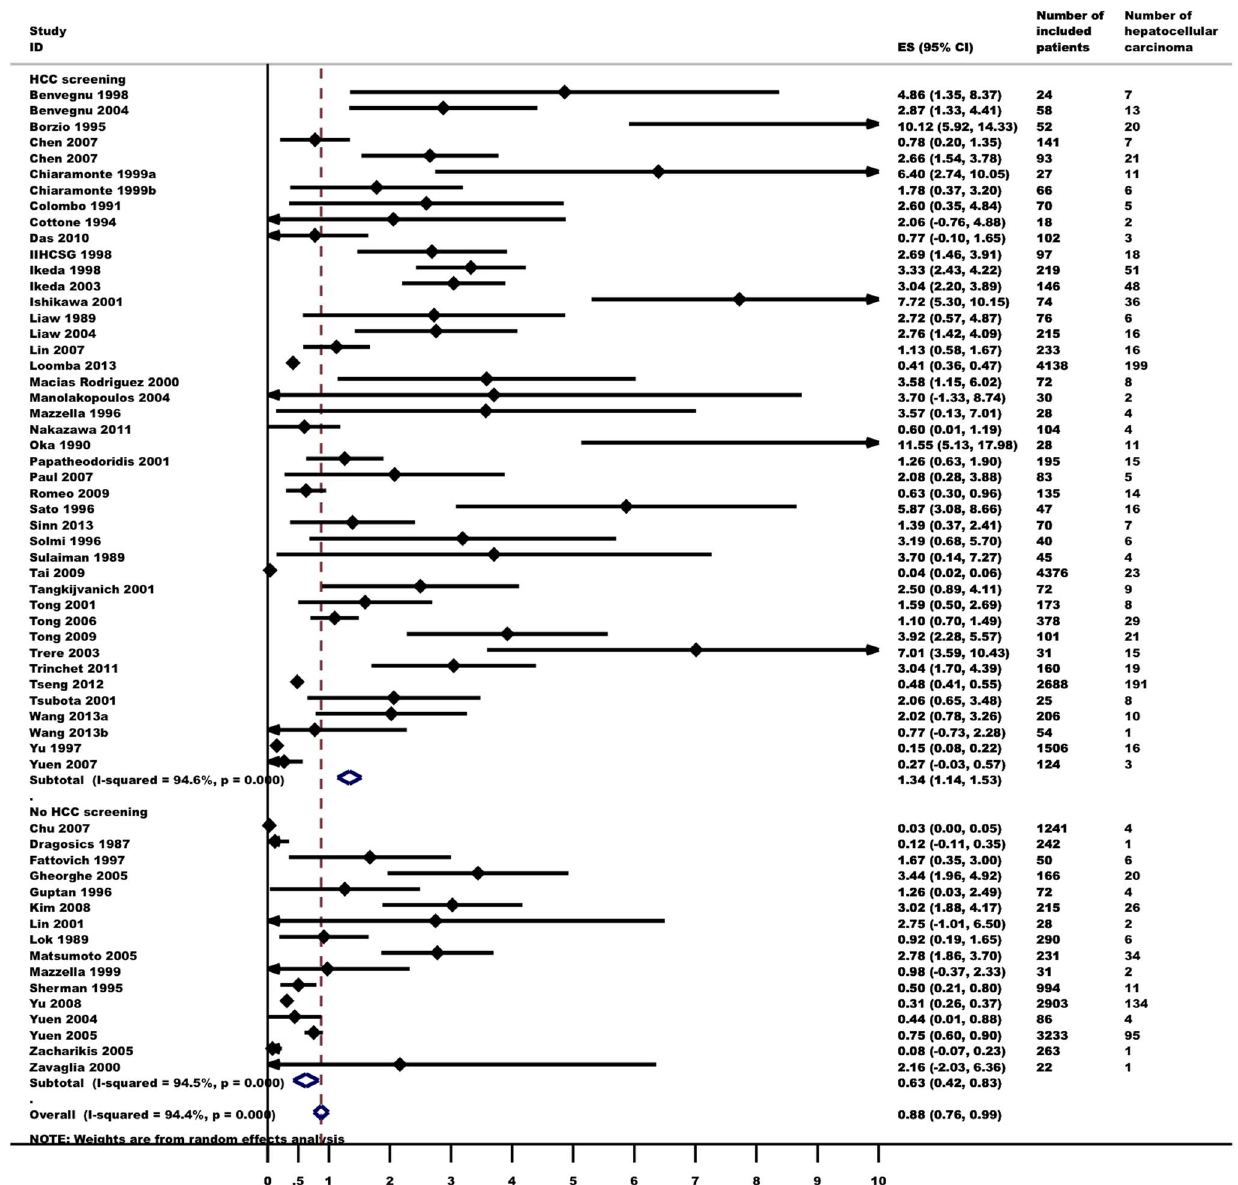
Figure 2. Annual incidence of hepatocellular carcinoma in untreated hepatitis B patients (events per 100 person-year). Random effects meta-analysis with subgroups according to HCC screening.